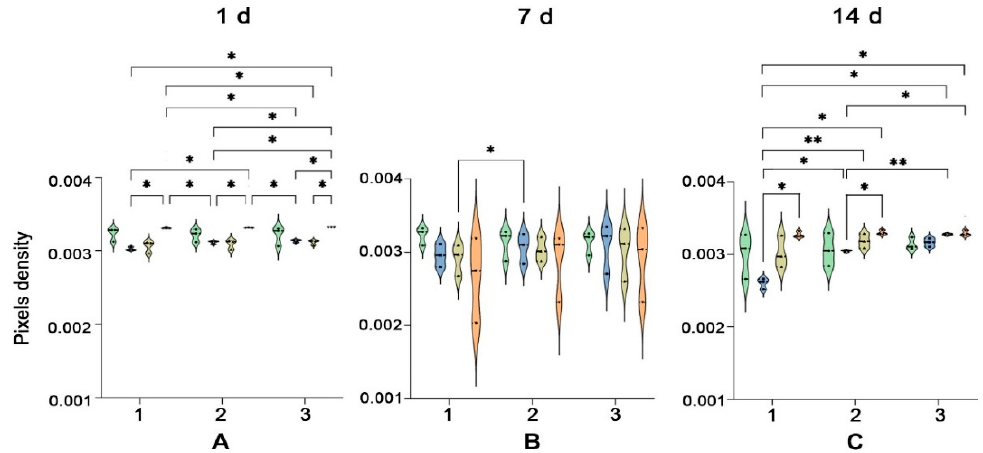
Figure 7. Quantitative analyses of picrosirius red staining imaging. Densitrometric data acquired using ImageJ for days 1 ( A ), 7 ( B ), and 14 ( C ) were compared with regard to seeding density (100 k, 300 k, 600 k, and control (no cells)). Three ROI are depicted: 1—close to cells, 2—at an intermediate distance from cells, and 3—cell-free area. Data represent n = 3 independent experiments assessed with two-way ANOVA multiple comparisons tests. * p < 0.05, ** p < 0.01.